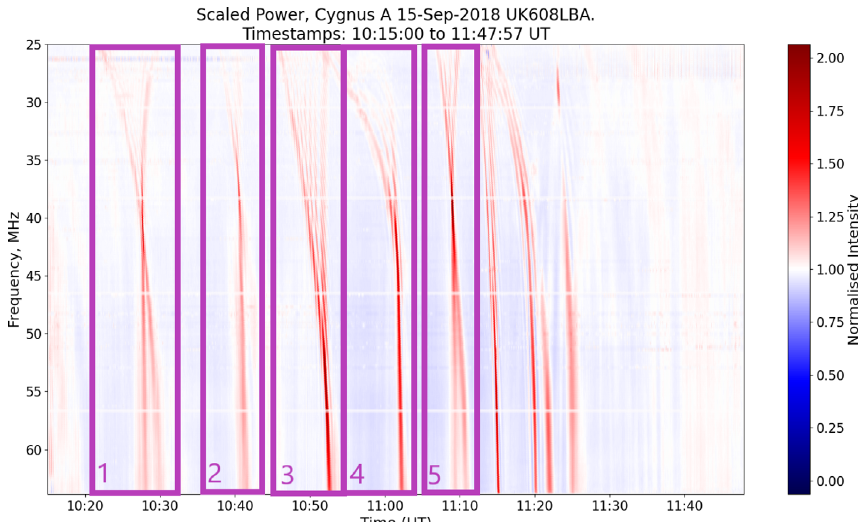
Fig. 1. The fi ltered dynamic spectrum of Cygnus A from the LOFAR station in the UK (station UK608: 51.1 (cid:3) N, 1.4 (cid:3) W, 176 m above sea level). The frequency scale is inverted, with lower frequencies at the top of the plot. The normalised intensity is the intensity after the fi ltering process, with a normalised intensity of 1 being the expected value for an undisturbed ionosphere. Individual features are numbered to distinguish them in further discussion. The horizontal white lines are the channels removed due to RFI contamination.